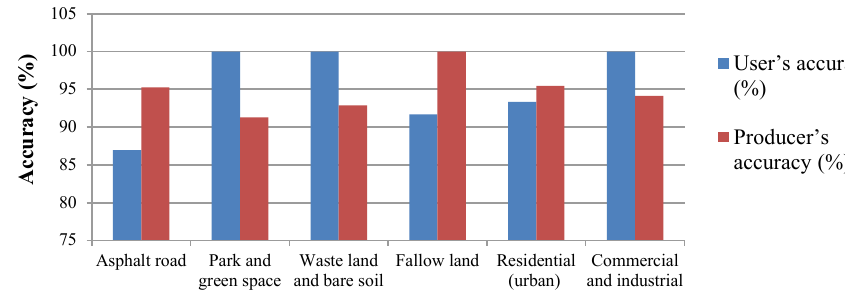
Figure 6. Land use classes User’s and producer’s accuracy of the 6 August 2009 Landsat TM image.